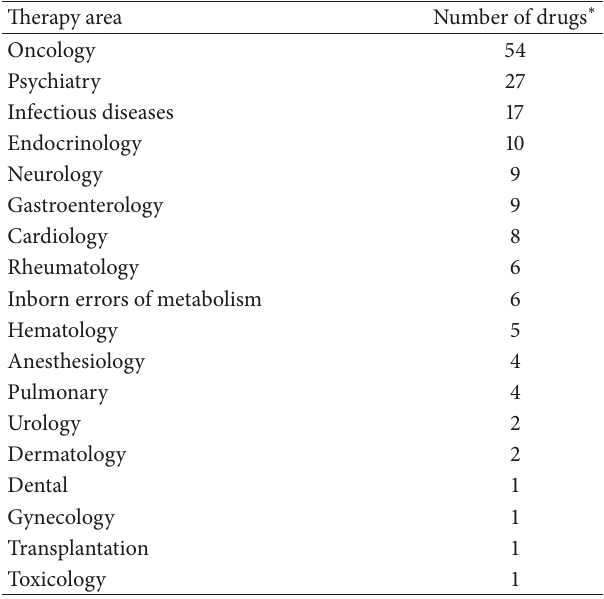
Table 2: Therapy areas using therapies with pharmacogenomic information in their